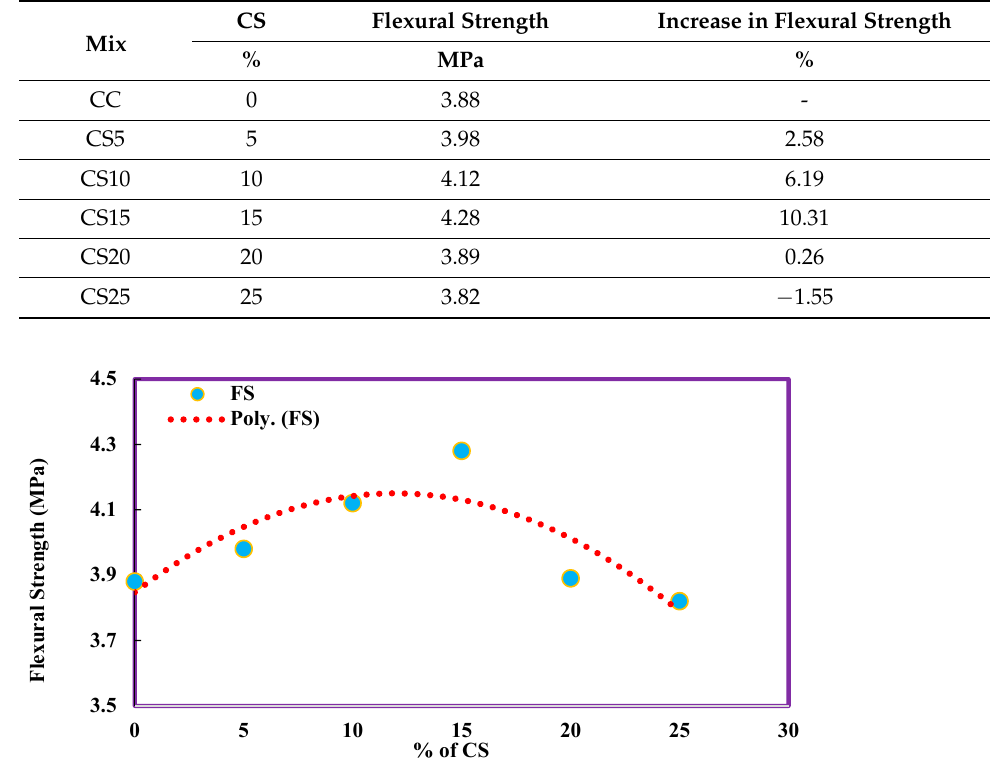
Figure 6. Flexural strength of CS concrete.